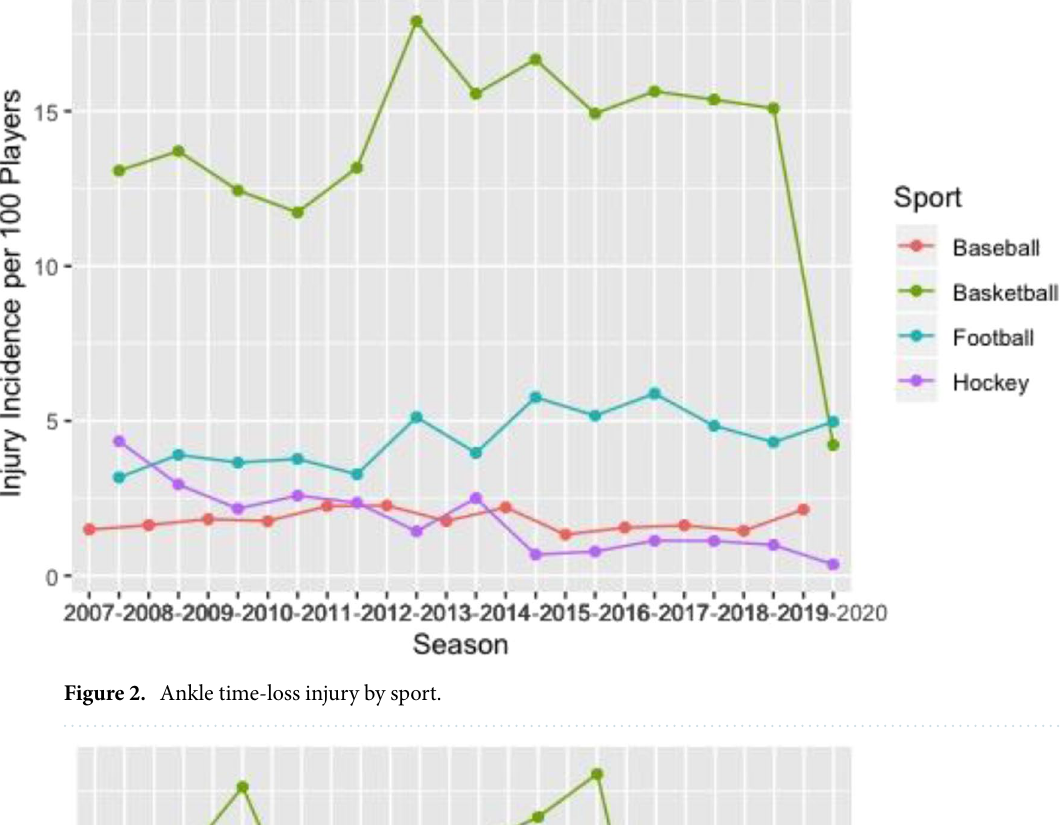
Figure 2. Ankle time-loss injury by sport.